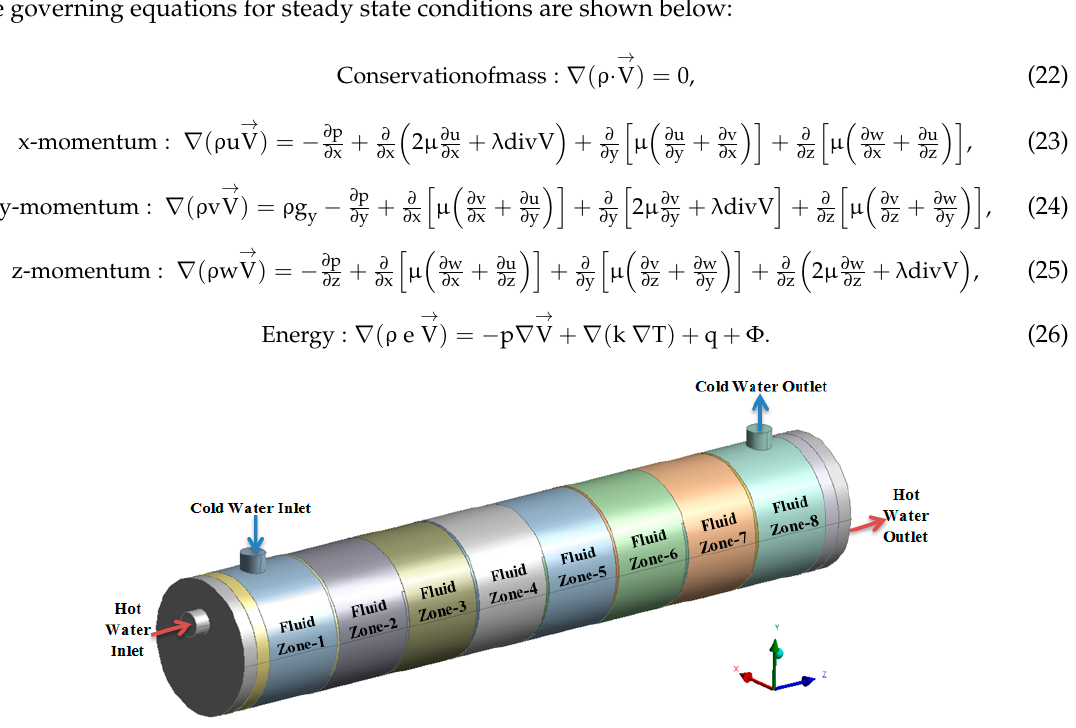
Figure 5. Separated fluid zones on the shell side of the heat exchanger.